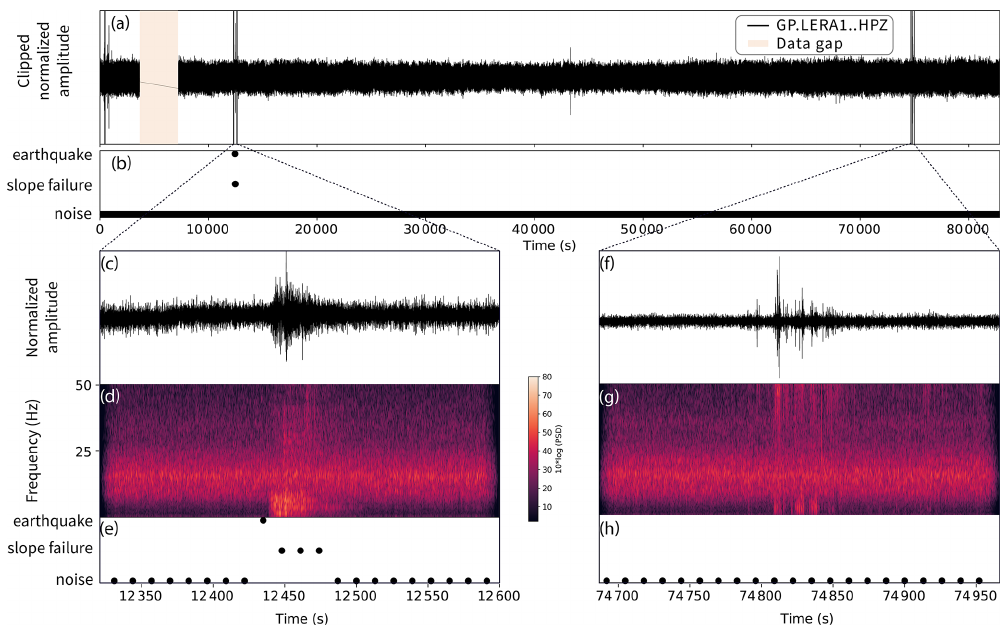
Figure 9. Classifier tested on 1d of data from Pizzo Cengalo in 2019 (16 July). (a) Waveform of 1d, with data gap (orange area). (b) Label of each 40s time window. (c) Waveform and (d) spectrogram with spectral power of a slope failure and (e) associated classifications. (f) Noise event with (g) spectrogram and (h) associated